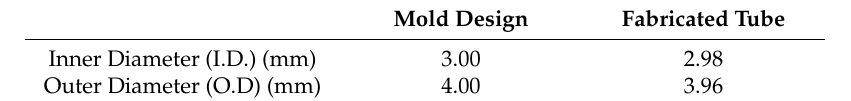
Table 1. Dimensions of the mold design and the fabricated tube.